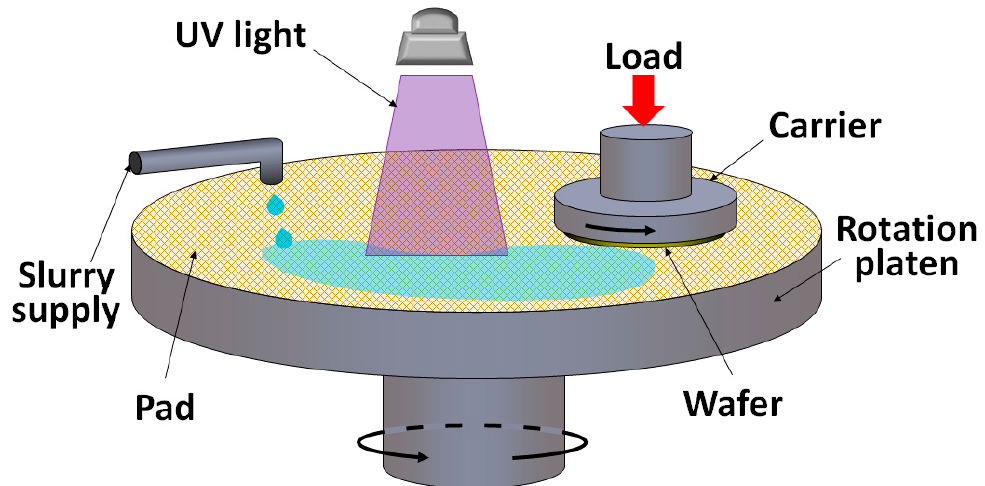
Figure 6. Typical setup for SiC PCMP.